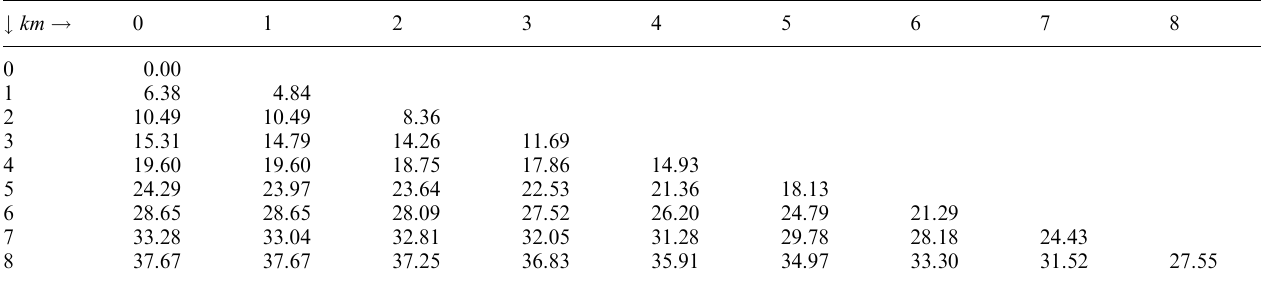
Table 1. Spherical cap noninteger degrees n k (cid:133) m (cid:134) for cap half angle # 0 (cid:136) 20 (cid:14) # km